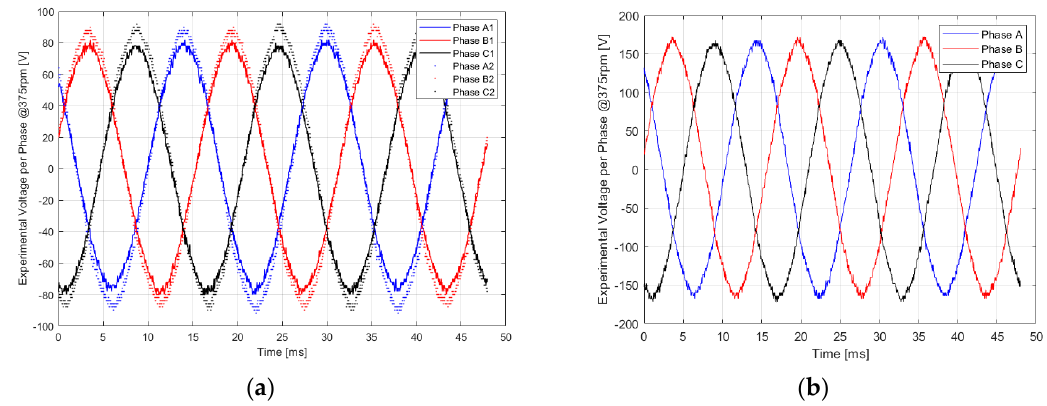
Figure 20. Experimental measurement curves of the EMF of the three phases: ( a ) when the phases of the two stators are disconnected from each other; ( b ) when the phases of the two stators are connected in series.